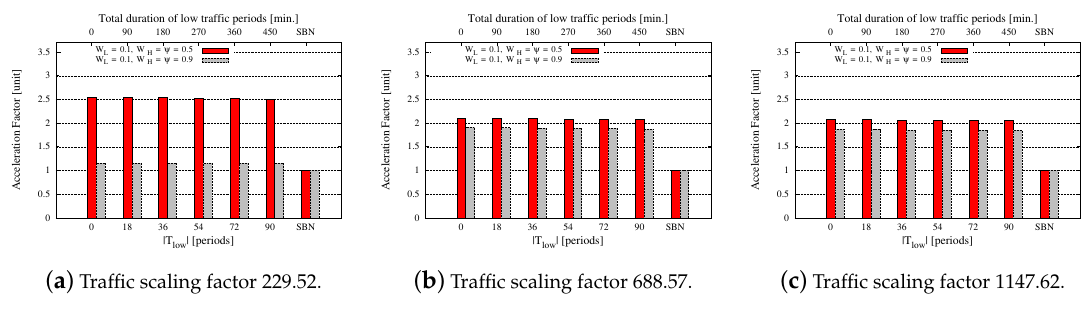
( b ) Traffic scaling factor 688.57. ( c ) Traffic scaling factor 1147.62. Figure 6. AF avg with AF sleep = 0.5 units and χ = 0.5 h/cycle after 14 days vs. the length of T low .